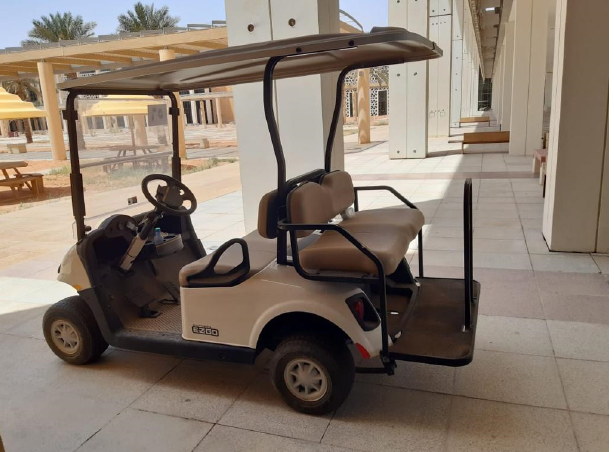
Figure 1. Princess Nourah Bint Abdelrahman University’s golf cart.